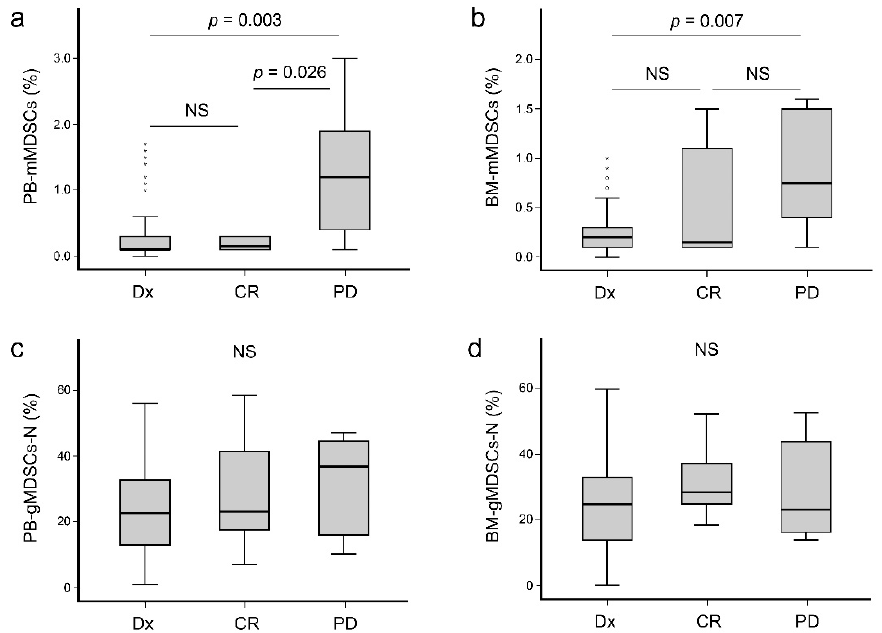
Figure 3. Comparison of myeloid-derived suppressor cells related to disease status of plasma cell myeloma. ( a ) PB-mMDSCs of patients with progressive disease showed higher levels than those of patients at diagnosis and in complete response ( p = 0.003 and 0.026, respectively). ( b ) BM-mMDSC levels were higher in patients with progressive disease than those in patients at diagnosis ( p = 0.007).